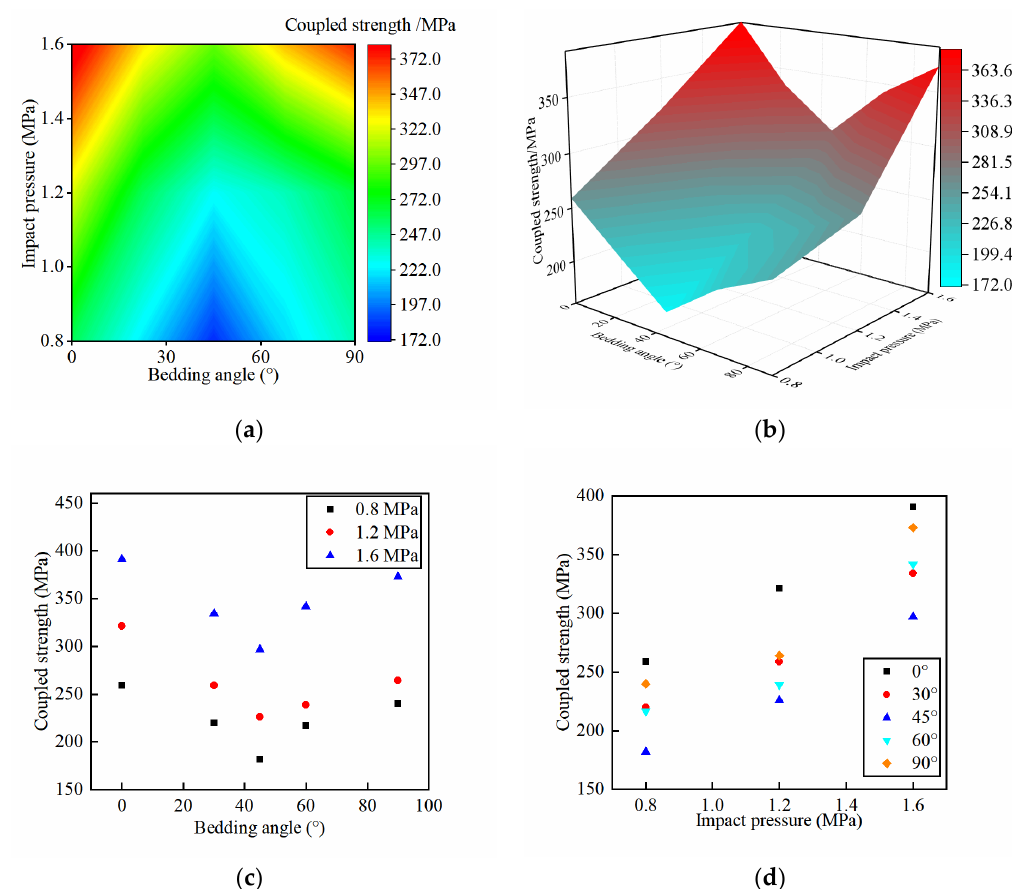
Figure 6. Peak strength of the sandstone samples under different loading conditions ( a ) Two-dimen- sional cloud map of peak strength. ( b ) Three-dimensional map of peak strength. ( c ) Different bed- ding angles. ( d ) Different impact pressure.